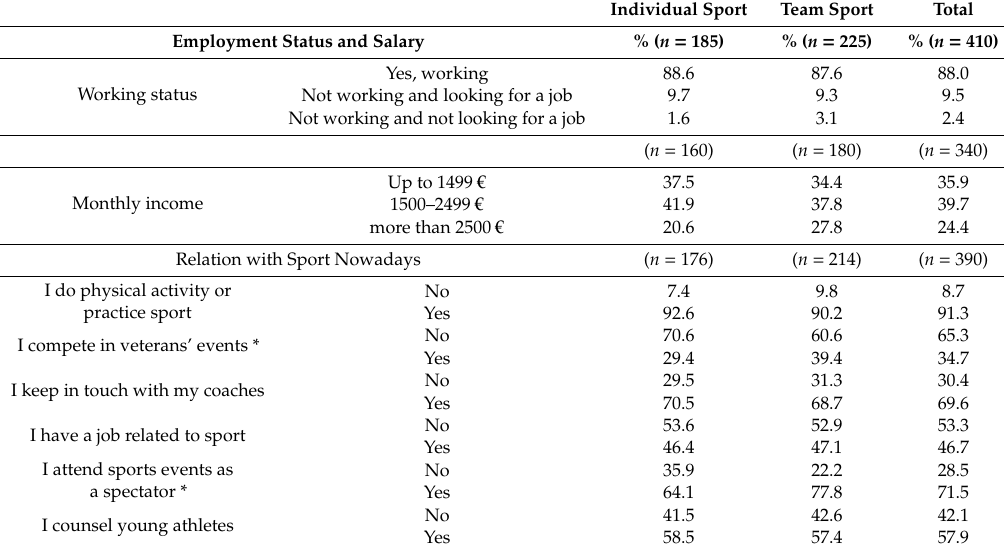
Table 3. Working status and relation with sport nowadays regarding the type of